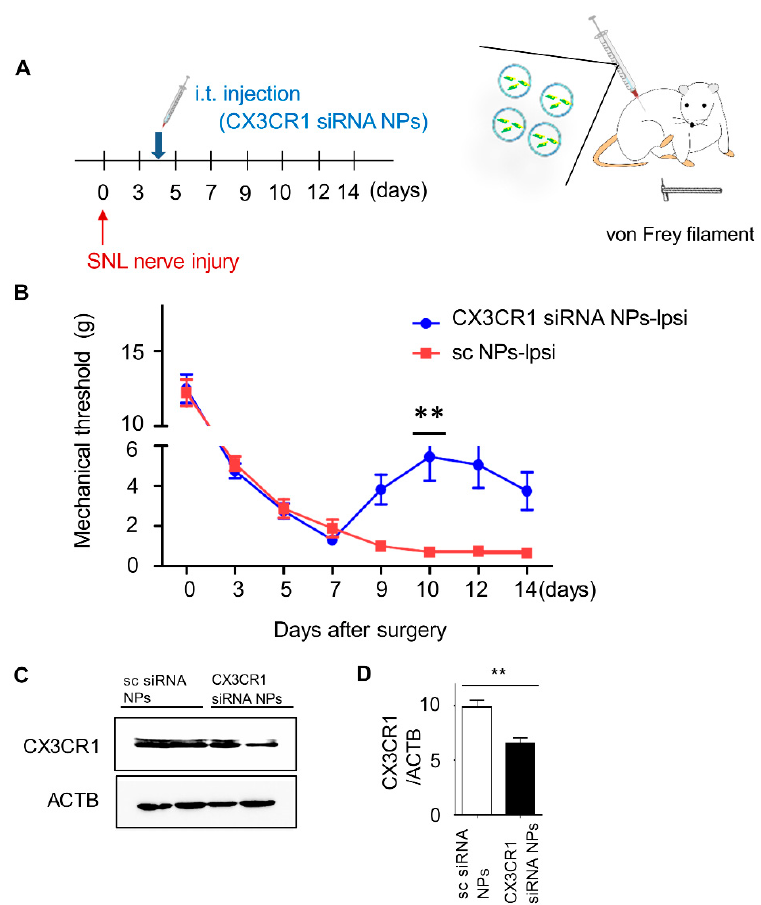
Figure 4. Intrathecal injection of PLGA-encapsulated CX3CR1 siRNA nanoparticles alleviates mechanical allodynia in spinal nerve ligation-induced rats. ( A ) sc siRNA or CX3CR1 siRNA nanoparticles were injected intrathecally at 4 days post-SNL nerve injury. ( B ) Rats were then subjected to pain behavior testing using von Frey filaments to evaluate the e ff ect of CX3CR1 siRNA on neuropathic pain. Data are presented as the mean ± SEM (one-way ANOVA with Dunnett’s post hoc test, ** p < 0.01 versus sc NPs-Ipsi), n = 7 per group. ( C ) At 6 days post-intrathecal injection, L5 spinal sections were made, and expression of CX3CR1 protein was detected by Western blot using an anti-CX3CR1 antibody, and the CX3CR1 / ACTB ratio was quantified. ( D ) Data are presented as the mean ± SEM ( t -test, one-way ANOVA, ** p < 0.01 versus sc siRNA NPs), n = 7 per group NPs, nanoparticles; i.t, intrathecal; sc, scrambled; Ipsi,